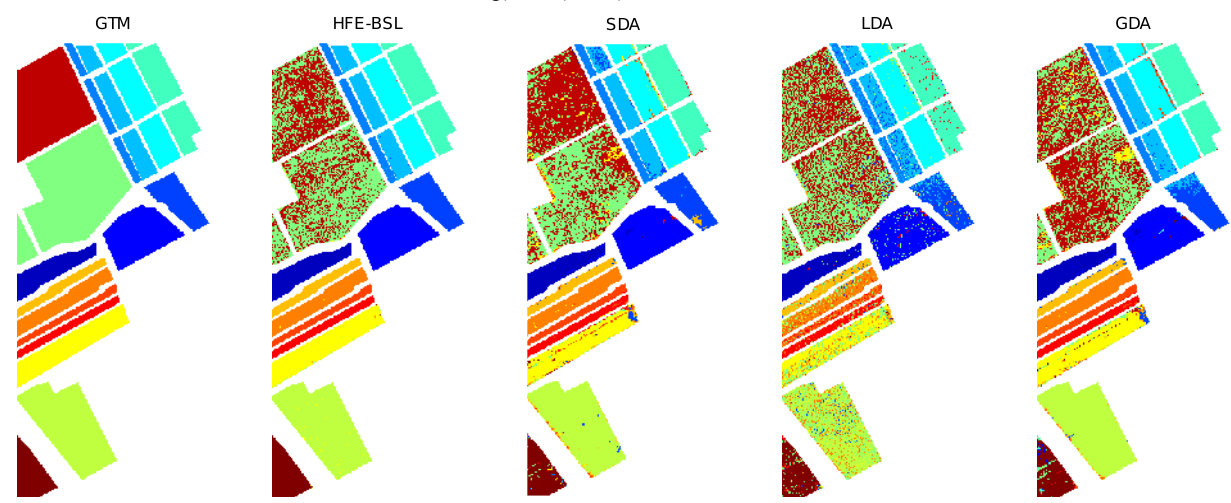
Figure 6. GTM and classification maps for Salinas dataset (16 training samples and 10 extracted features are Table 4. Mean and standard deviation of highest average classification accuracies (numbers in parentheses represent number of features achieving highest average accuracies in experiments).